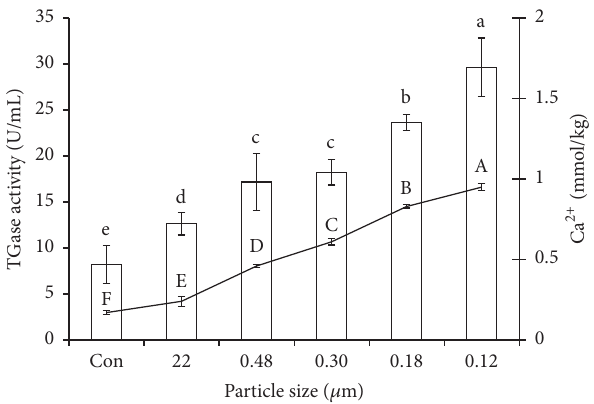
Figure 3: Endogenous TGase activity and calcium ion concen- tration from surimi paste as affected by added fish bone particle size. Column: TGase activity; line: calcium ion concentration. Con: control sample, without added fish bone. Different letters above the error bar indicate significant differences among samples with fish bone of different particle size ( 𝑃 < 0.05